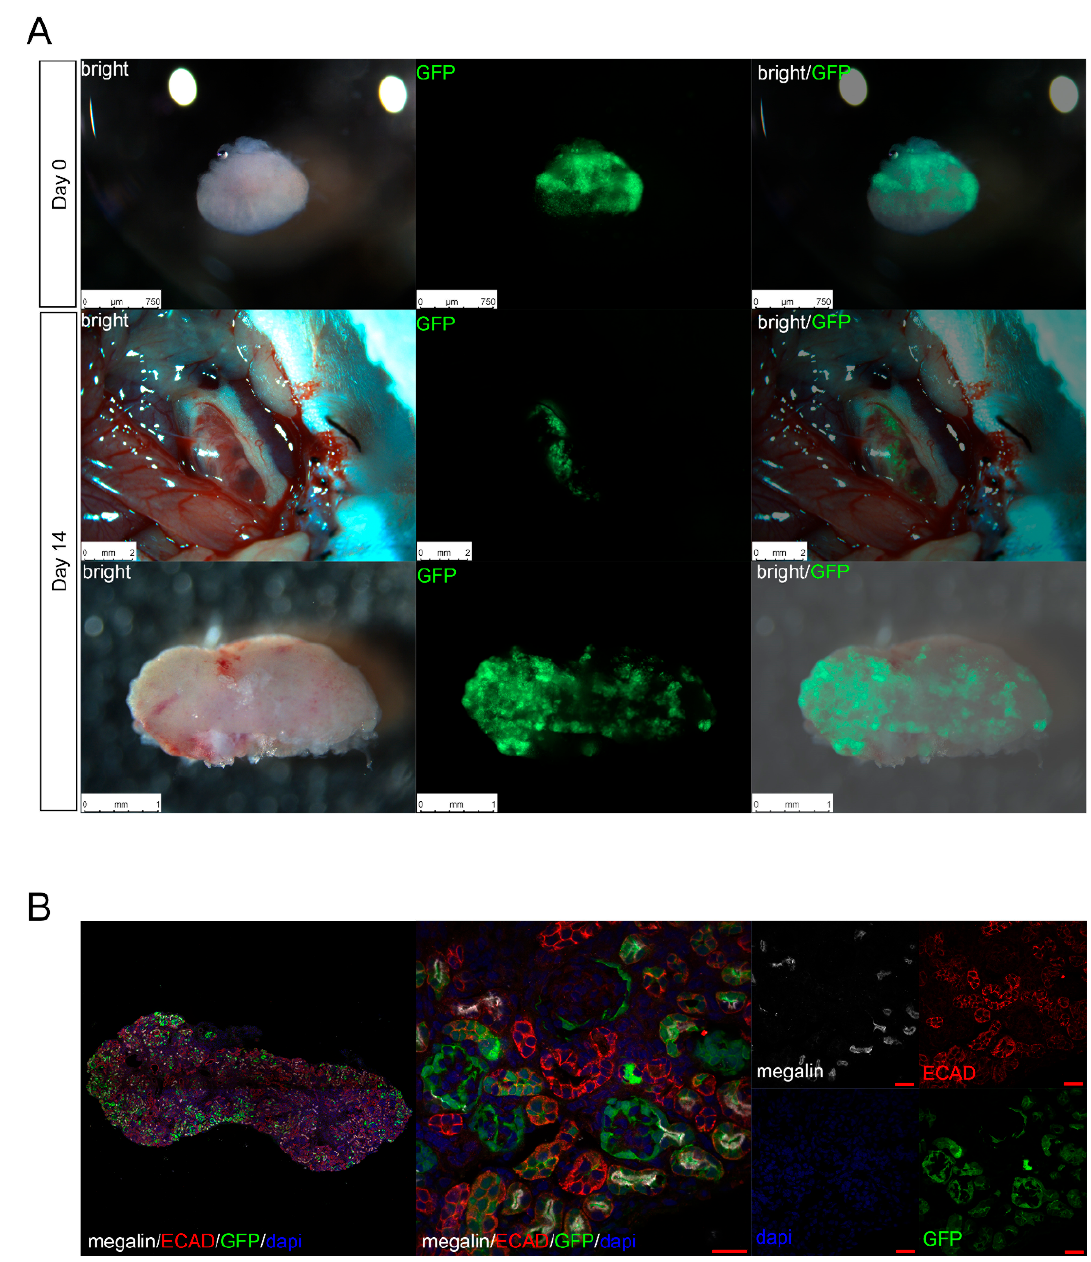
Figure 4. In Vivo regeneration of renal tissue using cryopreserved metanephroi. ( A ) Fluorescence stereomicroscopy images of cryopreserved E14.5 Six2-GCE+/diphtheria toxin fragment A+ mouse metanephroi injected with mouse green fluorescent protein (GFP) renal progenitor cells. The meta- nephroi were transplanted into NOD/Shi-Scid IL-2R γ KOJic mice and were harvested two weeks after transplantation. ( B ) Immunostaining of frozen sections created from the collected specimens revealed GFP-positive neo-glomeruli which originated from transplanted mouse GFP-renal progen- itor cells. Megalin-positive neo-proximal tubules and E-cadherin (ECAD)-positive neo-distal tu- bules can also be seen (scale bar, 20 μ m). DAPI, 4 ′